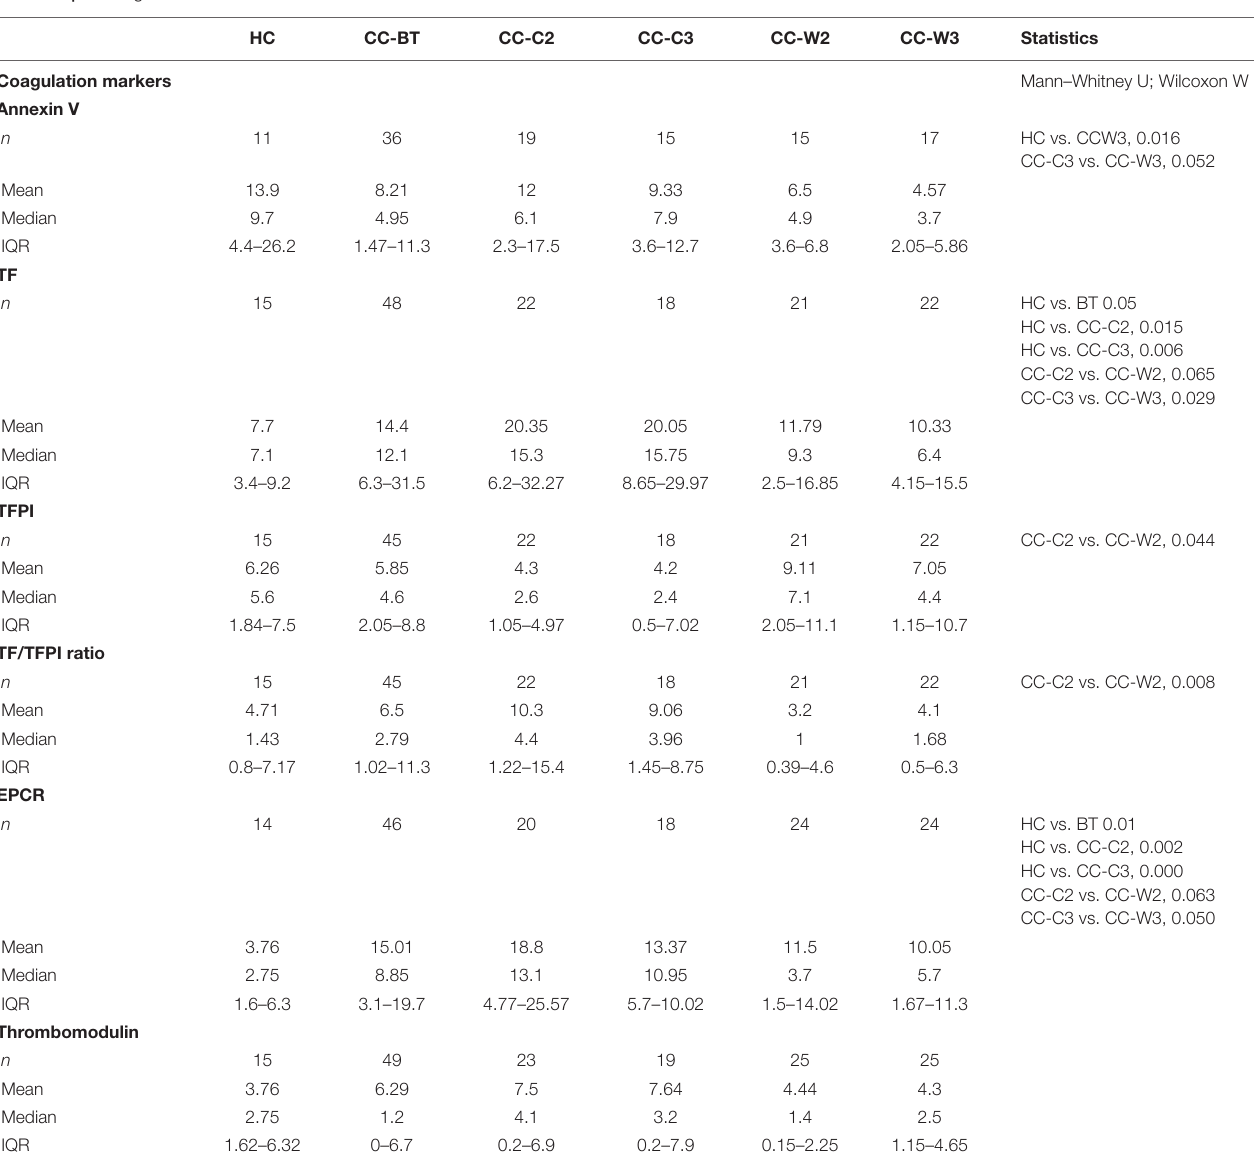
TABLE 3 | EV coagulation